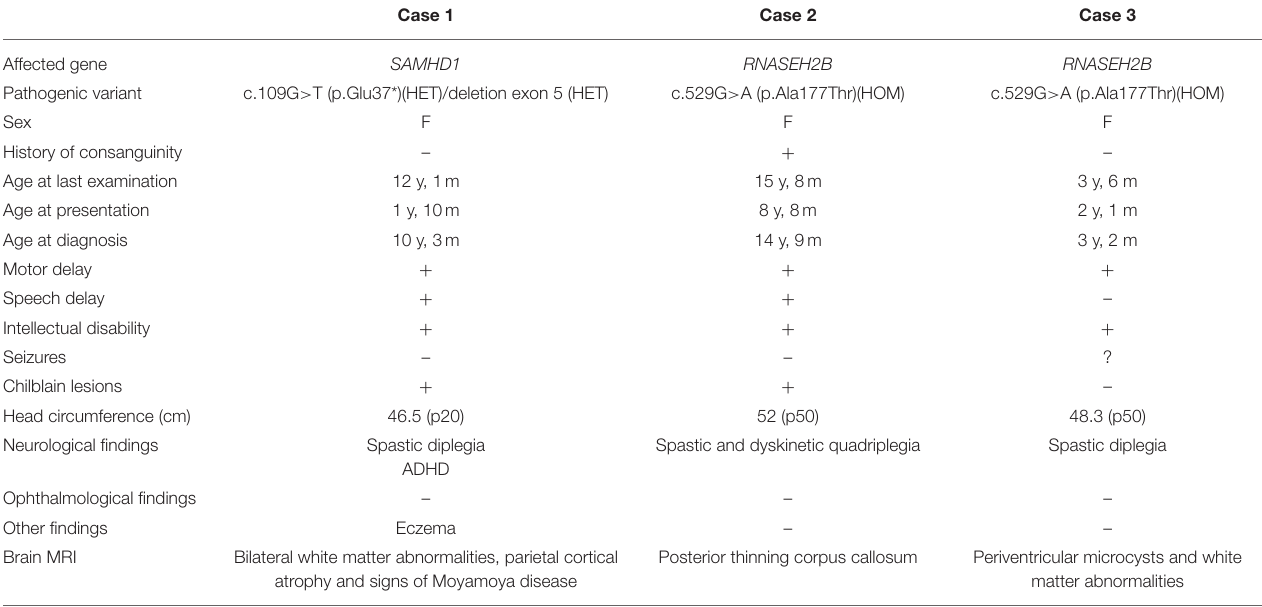
TABLE 1 | Summary of genetic and clinical findings of our AGS